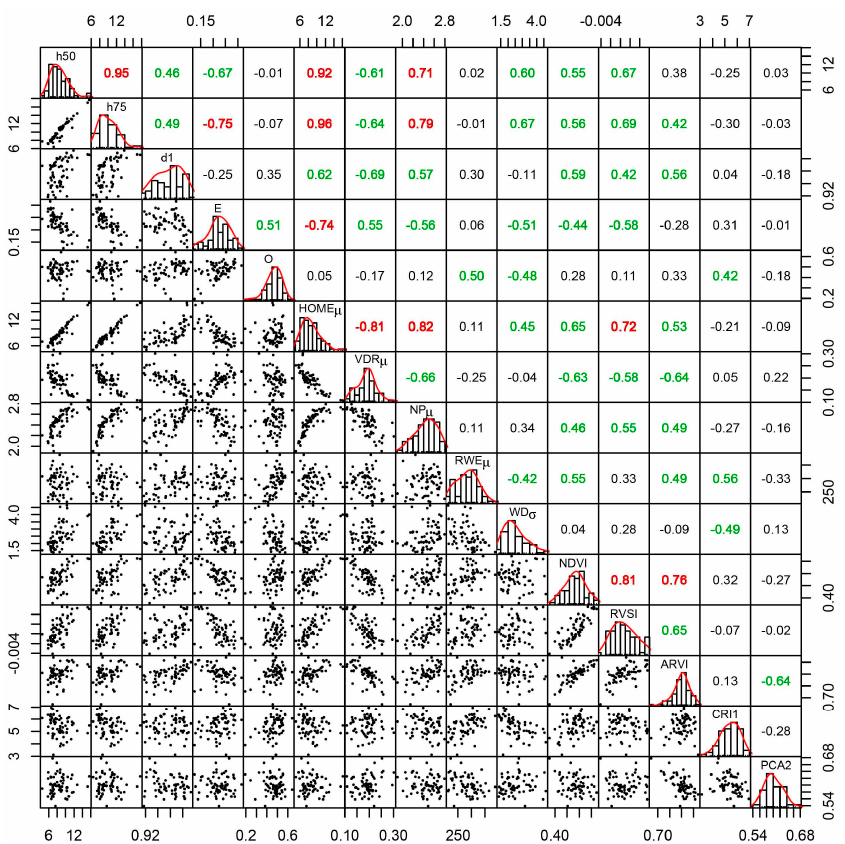
Figure 6. The matrix of the Pearson correlation coefficient ( r ) (upper panel) and scatter plots (lower panel) for the metrics in the combo models. The histograms and distributions are shown in the diagonal line. The red color represents a high degree of correlation ( r > 0.7), and the green color represents a medium degree of correlation (0.4 < r < 0.7). See Tables 3 and 4 for the description of metrics.